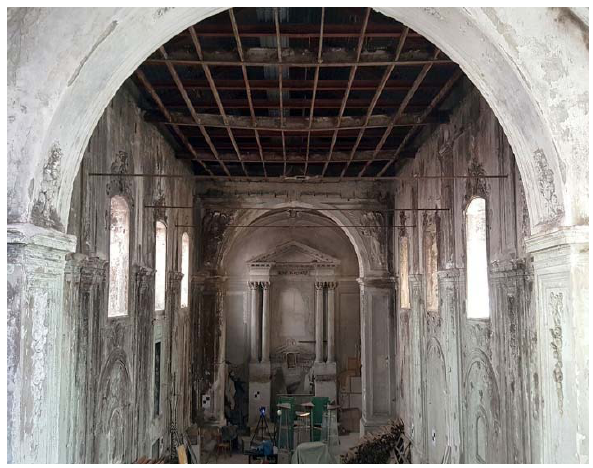
Figure 1: Indoor view of the Church of Rosario di